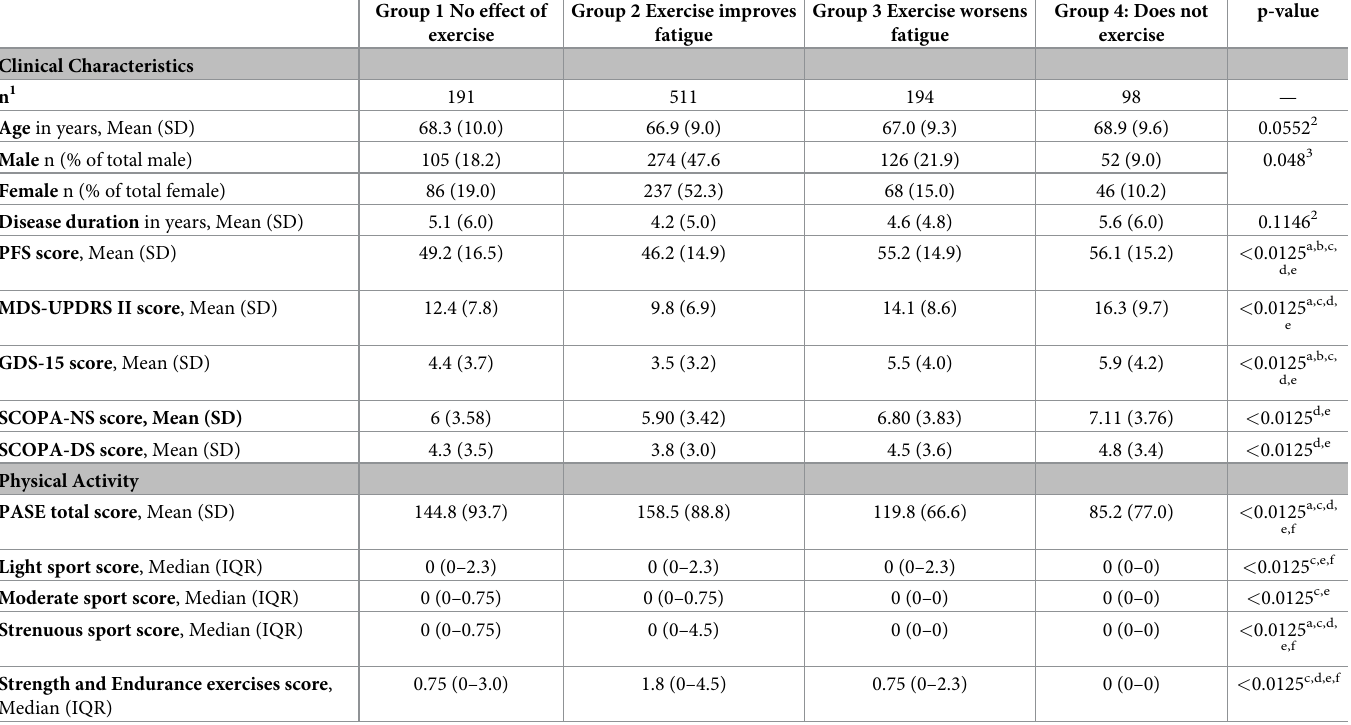
Table 4. Characteristics and activity levels in relation to perceived effect of exercise on